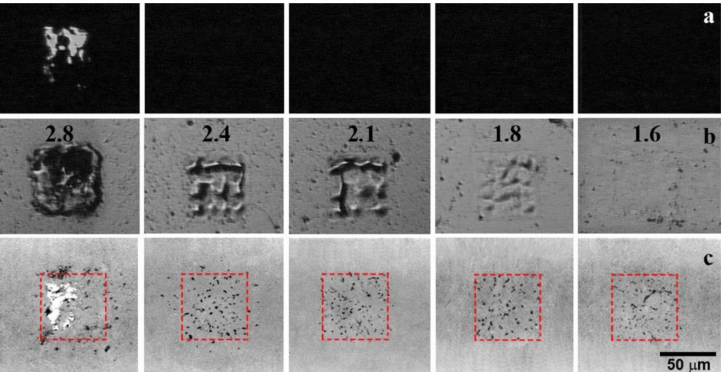
Figure 4. Optical images of the donor substrate covered by the graphene film in the ( a ) transmission and ( b ) reflection modes, and the ( c ) acceptor substrate after the BB-LIFT procedure with no gap between substrates. Numbers correspond to the laser fluence in J / cm 2 used for the